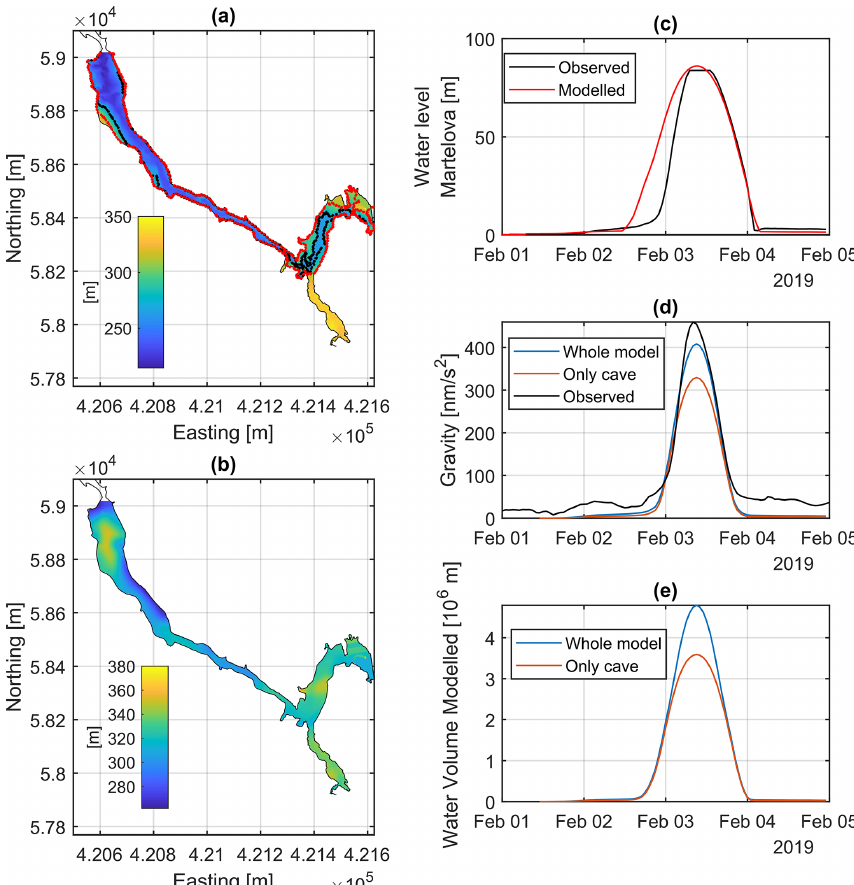
Figure B3. Modelling the flood event. (a) Height above sea level of the bottom of the channel where the Reka flows; the red and black outlines show the flooded area when the water level in P1 is respectively 86 and 50m. (b) Height above sea level of the ceiling of the cave. Panels (c) , (d) and (e) show results of the hydraulic model calculated, taking into account the new 3D model of the cave. (c) Observations (black) and modelling (red) of the water level time series in P1 (d) black: observed gravity residual; blue: modelled gravity transient for the whole model which includes the area outlined in B1a; red: gravity effect of the solely masses inside the cave. (e) Water volume fluxes during the flood; the colour code as in (e)